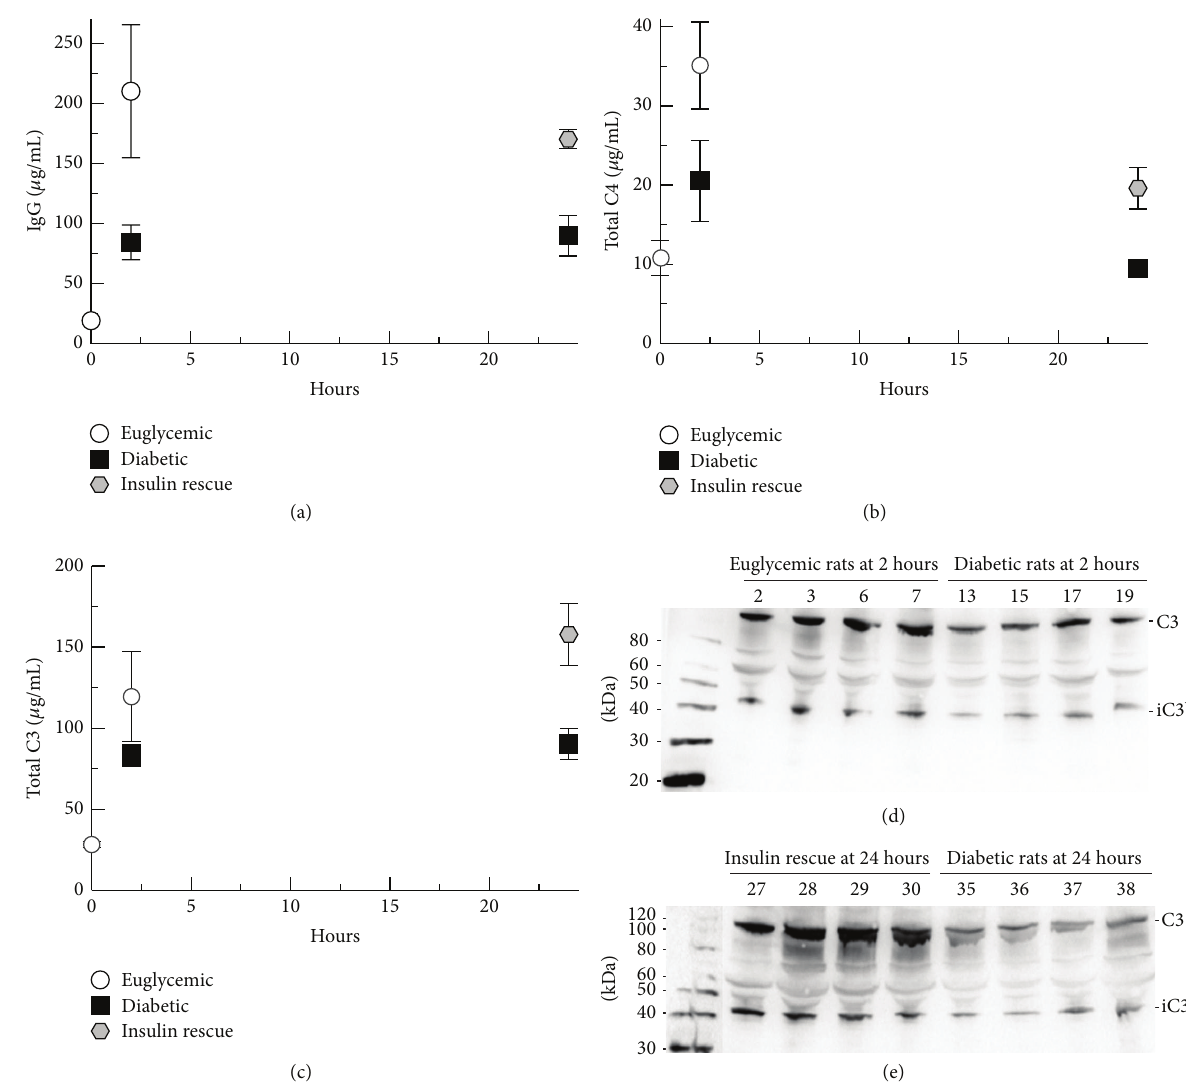
Figure 2: Humoral immune influx into the peritoneum. (a) IgG concentrations in peritoneal wash fluid assayed by SDS-PAGE. (b) Total C4 concentration in peritoneal wash fluid assayed by ELISA. (c) Total C3 concentration in peritoneal wash fluid assayed by ELISA. (d) C3- fragments in peritoneal wash fluid at 2 hours after infection analyzed by Western blot. (e) C3-fragments in peritoneal wash fluid at 24 hours after infection analyzed by Western blot. Graphed data shows means of results for peritoneal samples from the animals in each treatment group. Error bars denote standard error of the